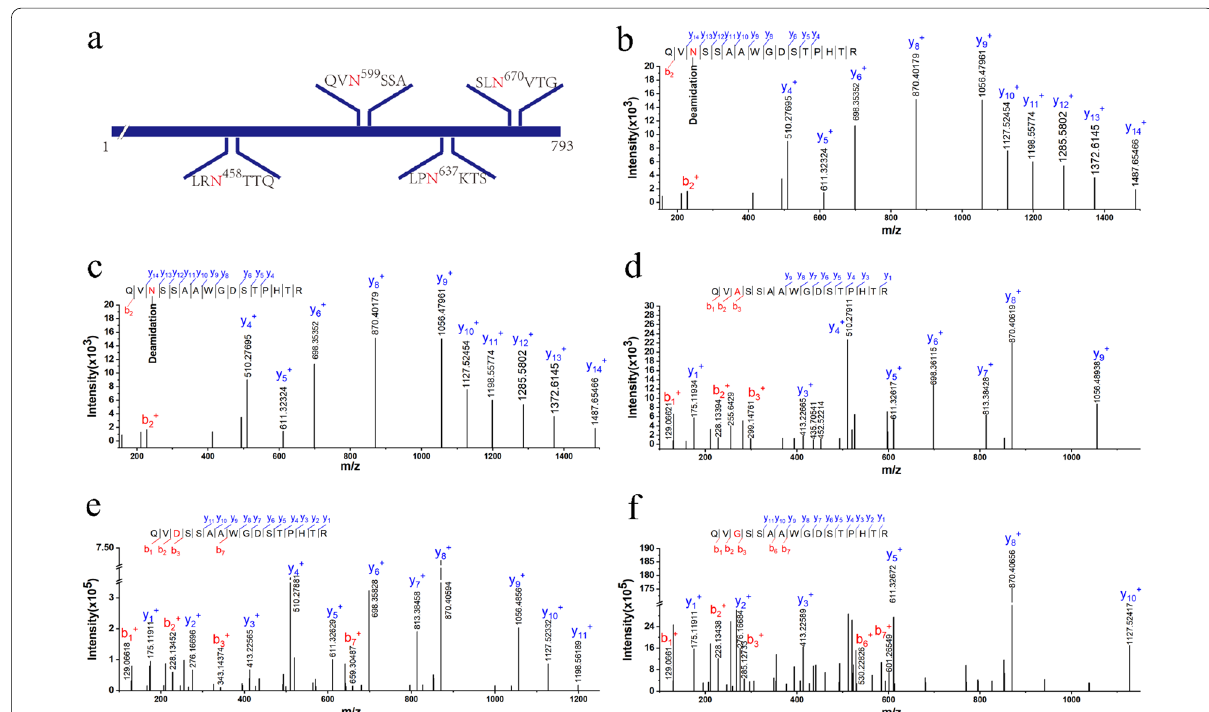
Fig. 2 The prediction and analysis of glycosylation sites in Ec Xly. a The schematic diagram of the 4 potential glycosylation sites in Ec Xly. The predicted N-glycosylation sites are shown in red letters. b – f A mass spectrum of the deglycosylated peptide from Ec Xly, Mi Xly, Ec Xly N599A , Ec Xly N599D and Ec Xly N599G ,